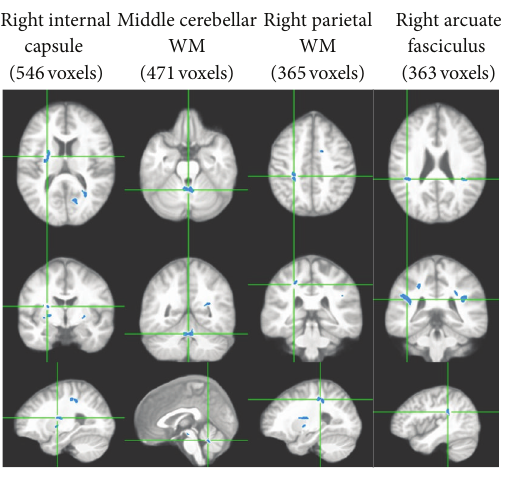
Figure 2: Four (out of 16) clusters all demonstrating significant WM FA reductions among patients with HTN and T2DM compared to those with HTN but no T2DM (VANCOVA analysis controlling for age, BMI, and the FLAIR image; significance shown for a minimum cluster size of 100 contiguous voxels; 𝑃 < 0.01 ). Each column shows three orthogonal orientations of the average normalized structural image illustrating a significant cluster with the axes passing through the centroid of the cluster (the Talairach space coordinates for the clusters are listed on Table 4).